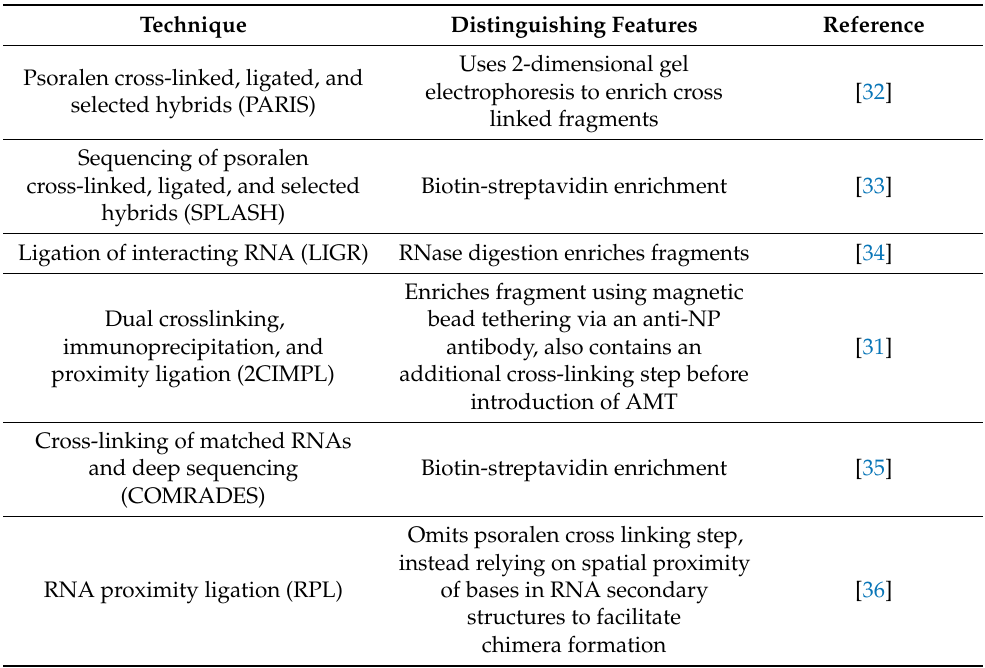
Table 2. Proximity ligation